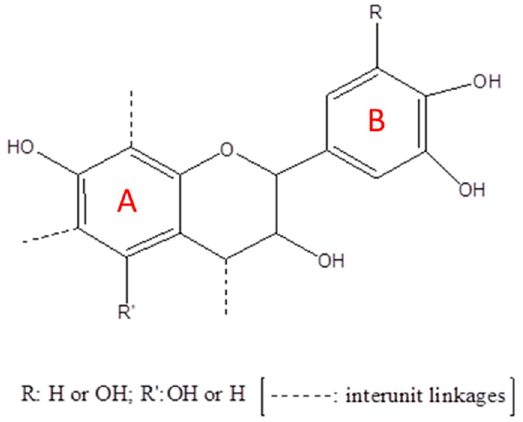
Figure 1. Chemical structure of tannins.